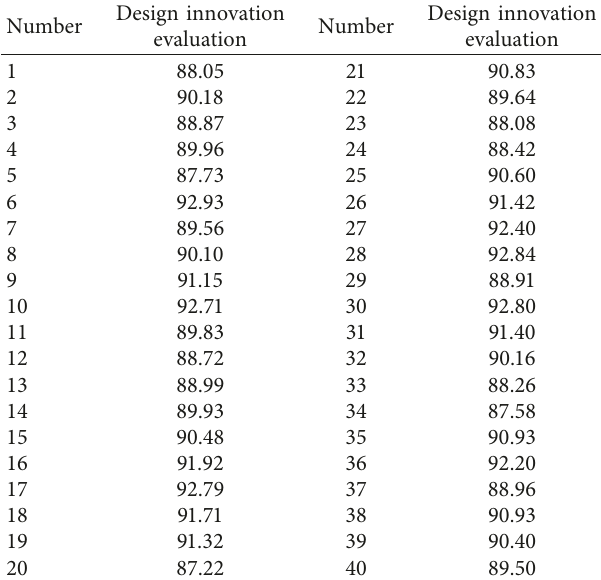
Table 2: Design innovation evaluation of sustainable development garden landscape design system based on data mining and virtual